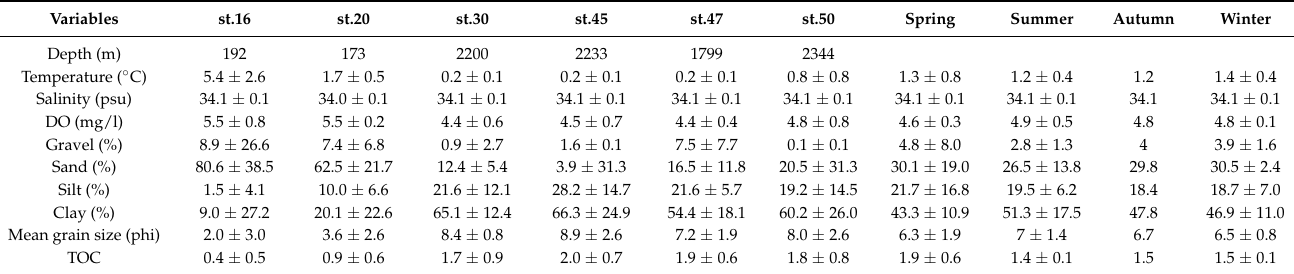
Table 1. Regional and seasonal environmental variables in the study